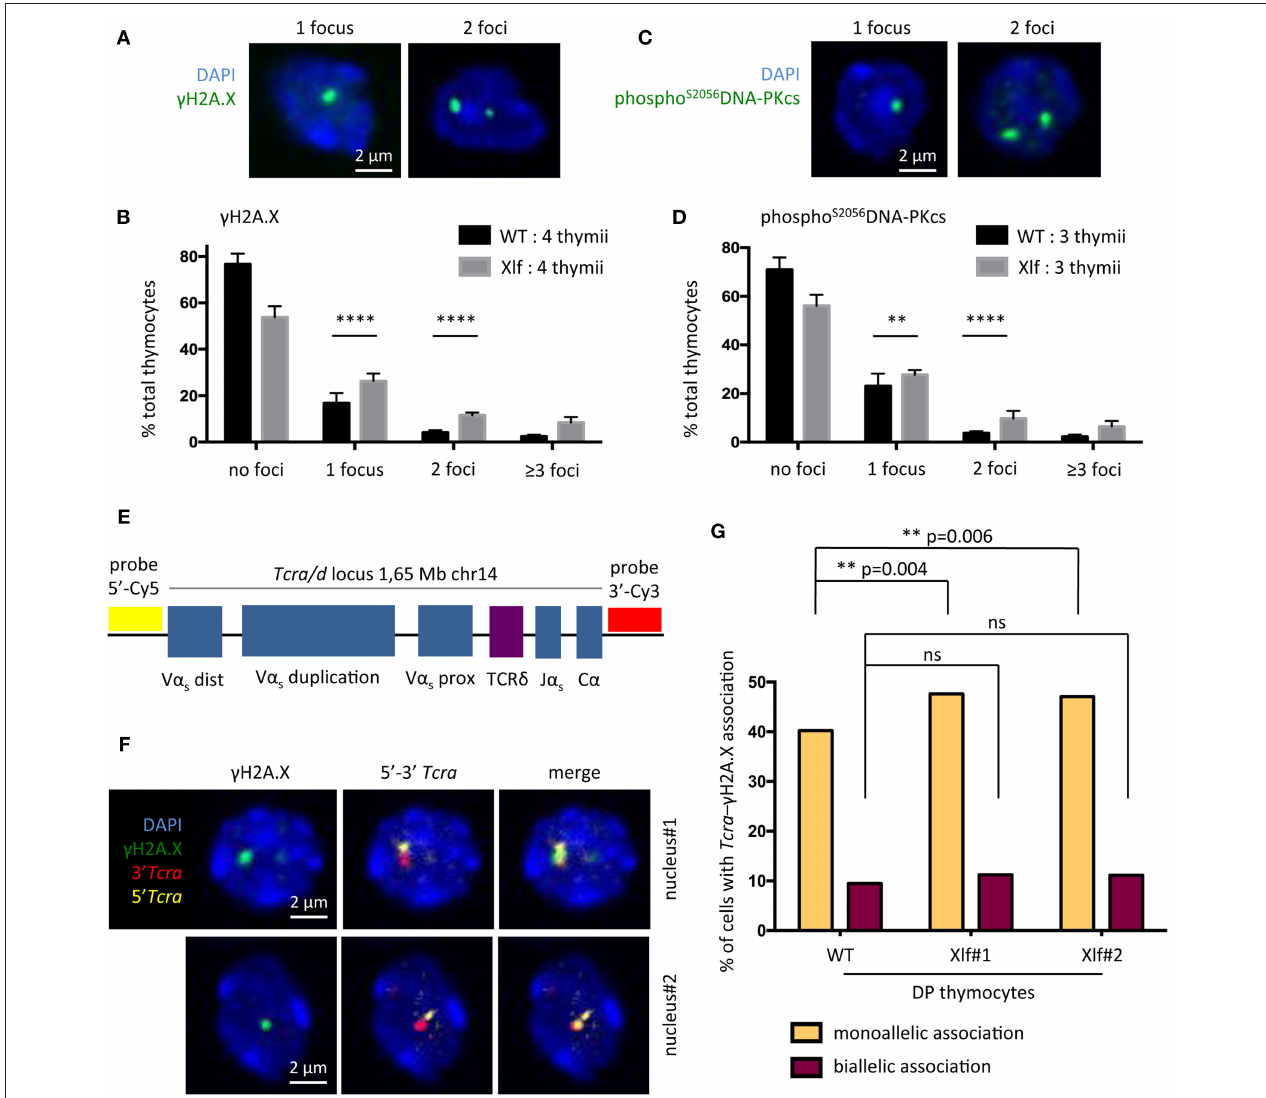
FIGURE 3 | DNA repair defect during TCR α rearrangement in Xlf − / − thymocytes. (A) γ H2A.X DNA repair foci 3-dimensional immunofluorescence in total thymocytes. (B) Quantification of thymocyte nuclei presenting 0, 1, 2 or more than 3 γ H2A.X foci. From 200 to 500 nuclei per thymus were scored. (C) Phospho S2056 DNA-PKcs DNA repair foci 3-dimensional immunofluorescence of in total thymocytes. (D) Quantification of thymocyte nuclei presenting 0, 1, 2 or more than 3 phospho S2056 DNA-PKcs foci. From 200 to 500 nuclei per thymus were scored. (E) Schematic representation of the Tcra/d locus in mice and positions of the probes used for DNA-FISH. RP23-255N13 and RP23-304L21 BAC probes label the 3 ′ and 5 ′ edges of the Tcra/d locus, respectively. (F) 3-dimensional Immuno-DNA-FISH analysis of TCR α rearrangement in sorted CD4 + CD8 + DP thymocytes in 2 independent nuclei. A γ H2A.X focus associated with Tcra locus indicates an ongoing TCR α rearrangement. (G) Quantification of CD4 + CD8 + DP thymocyte nuclei displaying 1 or 2 Tcra - γ H2A.X association. 1 thymus from a WT mouse and 2 thymii from Xlf − / − mice were analyzed. Around 550 nuclei per thymus were scored. P -values were calculated using two-tail Fisher’s exact test (B,D,G) .